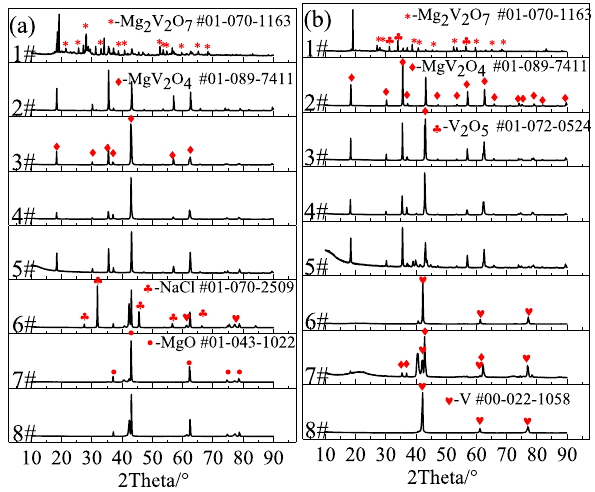
Figure 3: XRD pattern of the products: ( a ) before acid leaching and ( b ) after acid leaching.